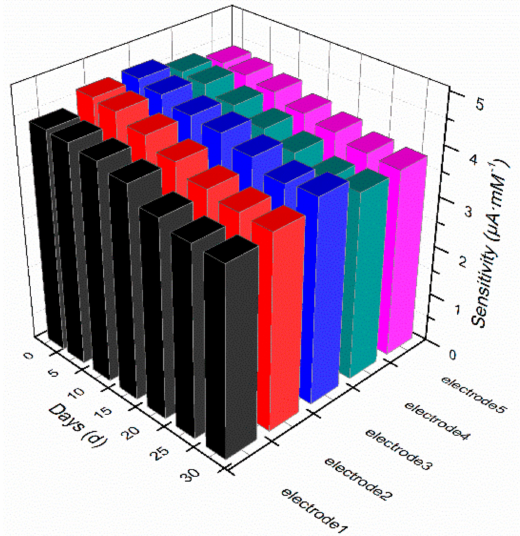
Figure 7. Research of stability and reproducibility of five GOD-BLG-PtAuPd-RGO/GC electrodes upon successive additions of glucose detecting every five days and continued for 30